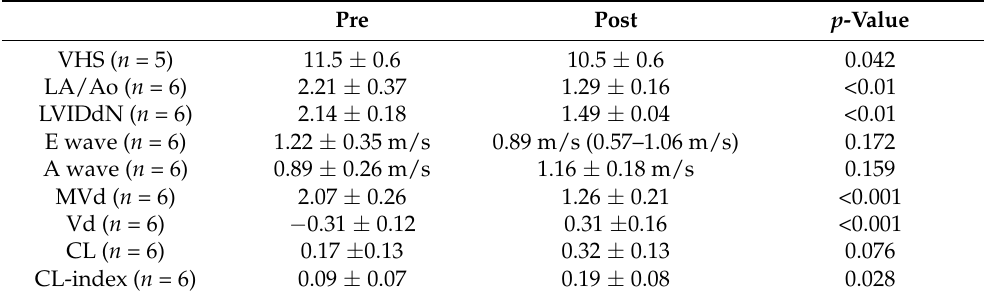
Table 2. Comparison of radiographic and echocardiographic measurements before and after sur- gery.